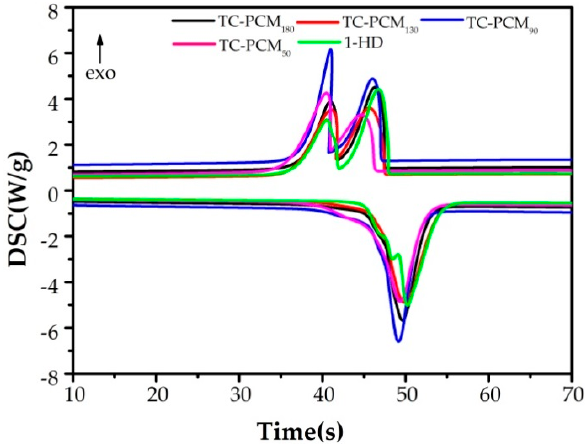
Figure 3. Curves of TC-PCM 180 , TC-PCM 130 , TC-PCM 90 , TC-PCM 50 , and pure 1-HD.